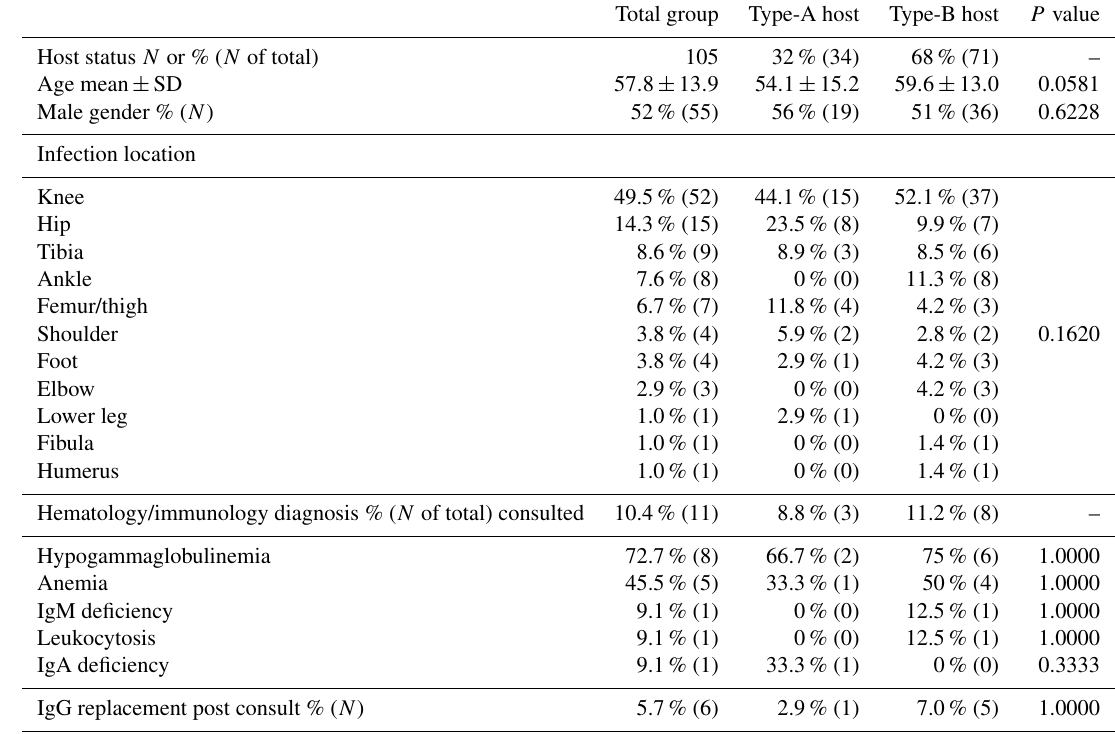
Table 1. Patient